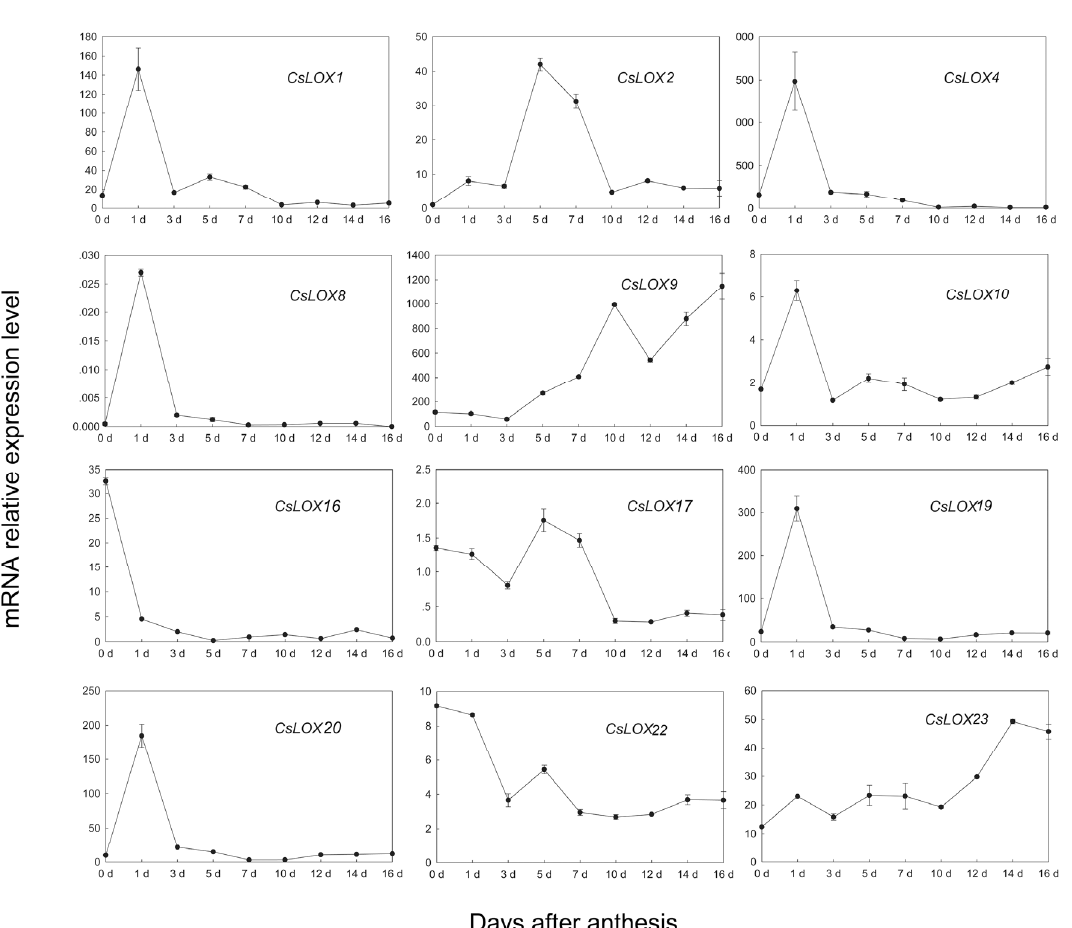
Figure 2. Expression profiles of LOX genes in cucumber ( Cucumis sativus ) cv Line 9930 (a cultivar of northern China) fruits analyzed using Quantitative Real-time PCR. The expression profiles of 12 fruit CsLOX genes were analyzed by using Quantitative Real-time PCR during cucumber fruit development after anthesis. Y -axis represents relative expression values, and the expression level of CsLOX2 in the 0 day after anthesis was considered as 1-fold. Data represent the means ± SD of three biological replicates. The expression of all the genes was normalized with reference to the expression of CsUBQ